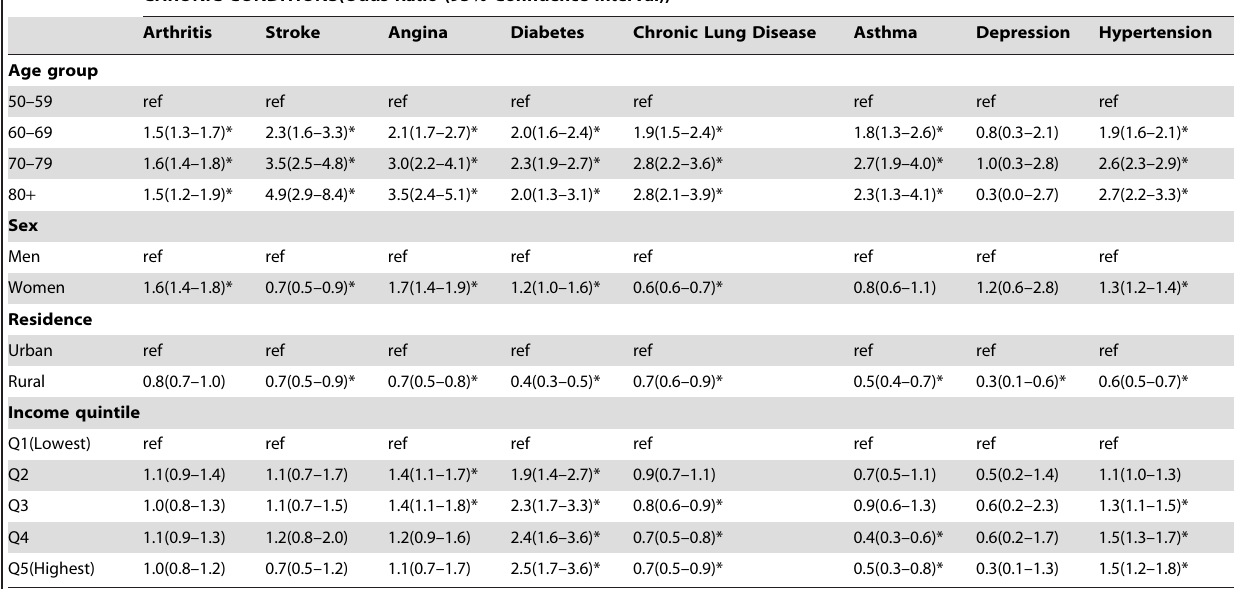
Table 4. Multivariate logistic regression of the effects of sociodemographic variables on presence of chronic